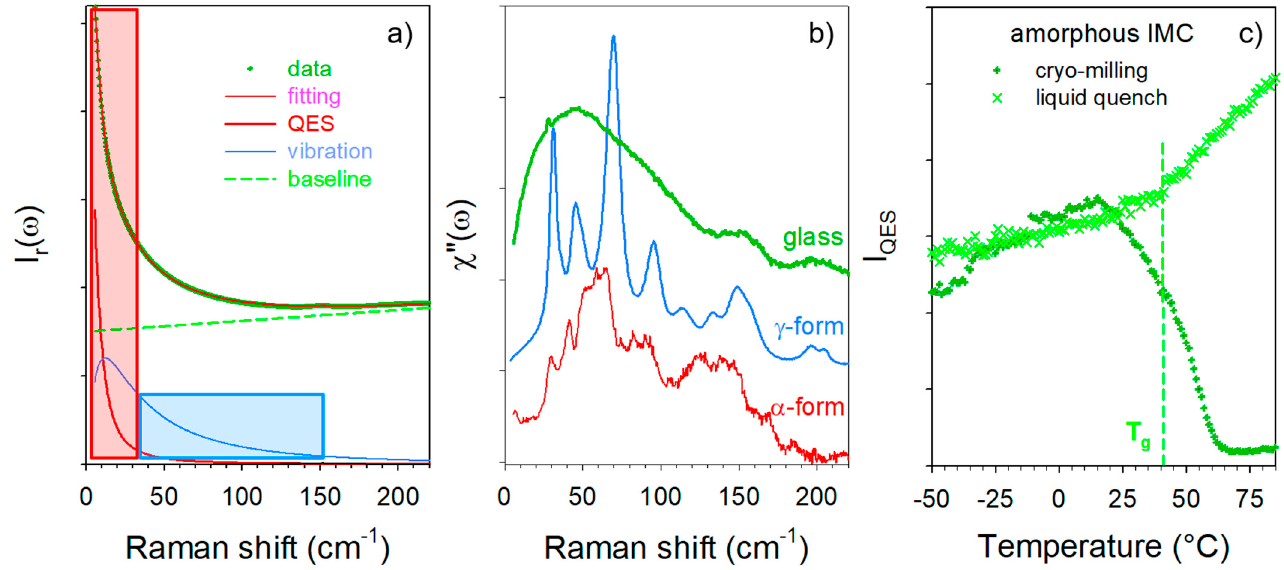
Figure 1 . Low-frequency analysis of amorphous indomethacin. ( a ) Description of the fitting proce- dure of the reduced intensity (Ir( ω )) spectrum used for separating quasielastic scattering from the vibrational spectrum. The blue area was used for the spectrum renormalization while the red area is proportional to the quasielastic intensity. ( b ) Representation of the vibrational spectrum in Raman susceptibility very close to the VDOS of glassy IMC compared with the lattice mode spectra of α and γ polymorphs at room temperature. ( c ) Temperature dependence of the quasielastic intensity calculated in amorphous IMC prepared by cryo-milling and by quenching the liquid.